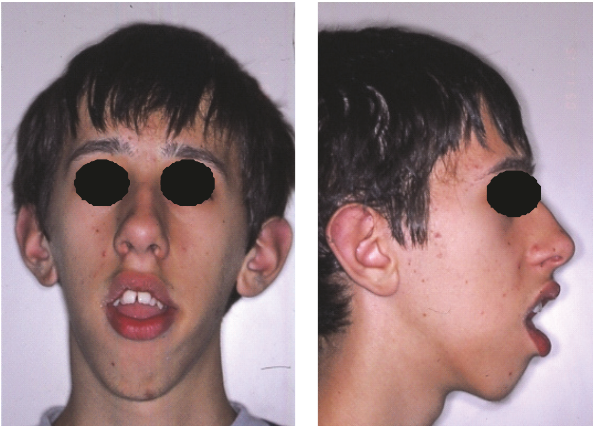
Figure 1: Front and lateral photographs of the patient at the time of the first